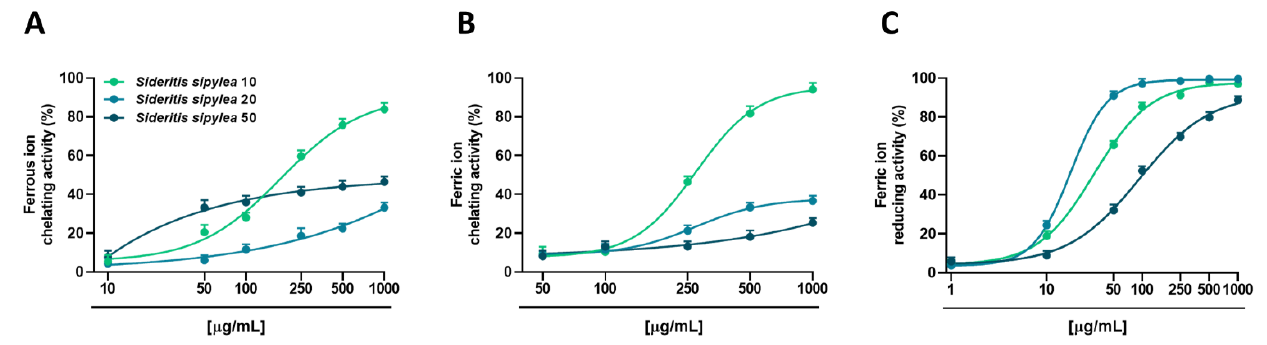
Figure 2. Ability of S10, S20, and S50 fractions from Sideritis sipylea Boiss to chelate ferrous ( A ) and ferric ( B ) ions, and to reduce ferric ( C ) ones. Data represent the average and standard error of at least three independent experiments ( n = 3) .